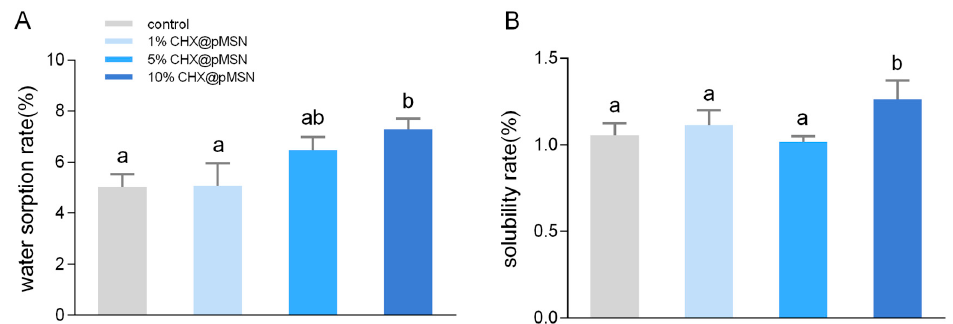
Figure 7. Water sorption rate ( A ) and solubility rate ( B ) of control, 1%, 5%, and 10% CHX@pMSN groups. Data are shown as mean ± standard deviation. The groups labeled with the same letters have no significant difference ( p > 0.05).